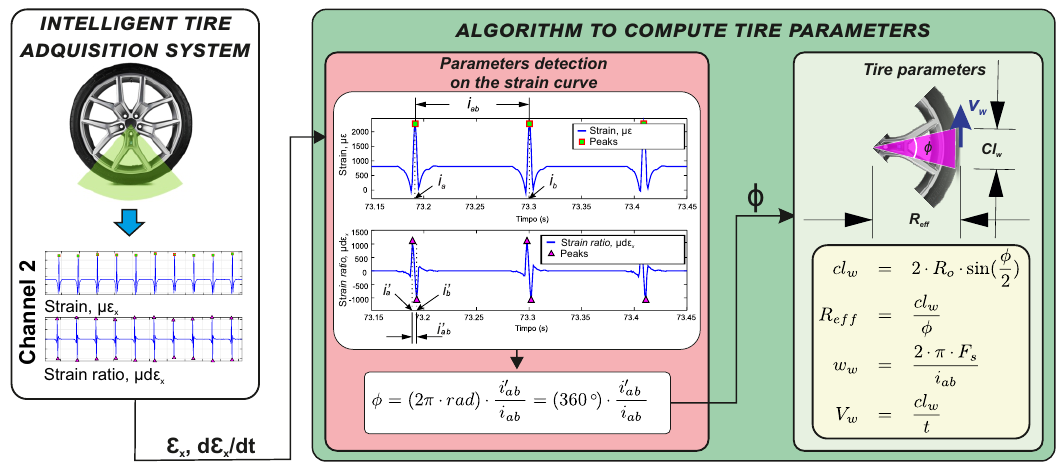
Figure 4. Workflow for the development of the intelligent tire detection